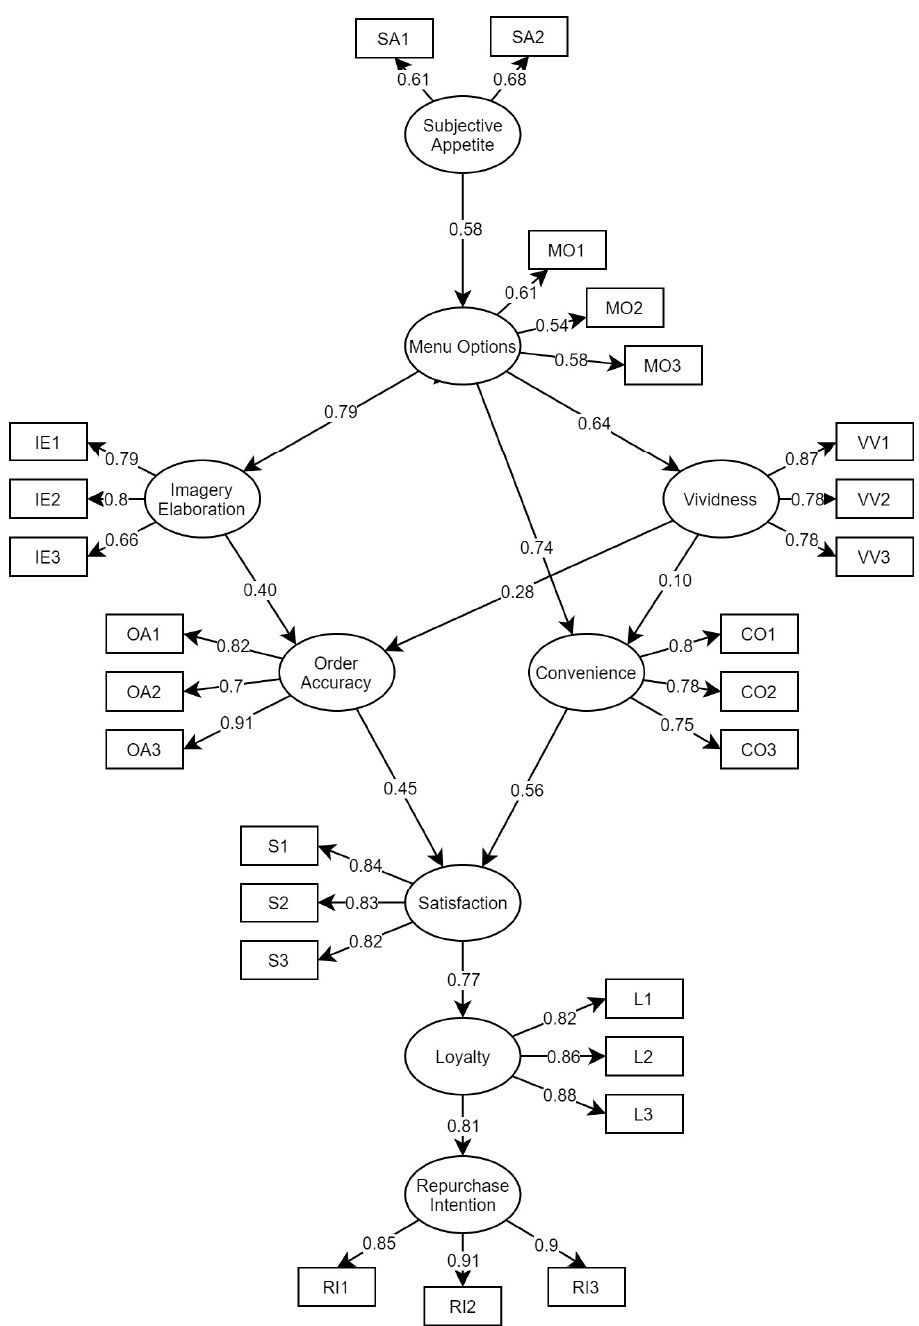
Figure 2. The final SEM for evaluating factors influencing customers’ repurchase intention in drive-through fast foods, in the Philippines.